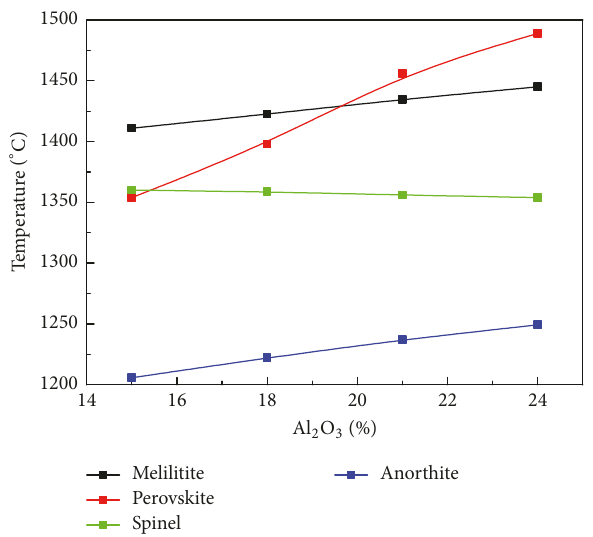
Figure8:CrystallizationtemperaturewithdifferentAl 2 O 3 contents.